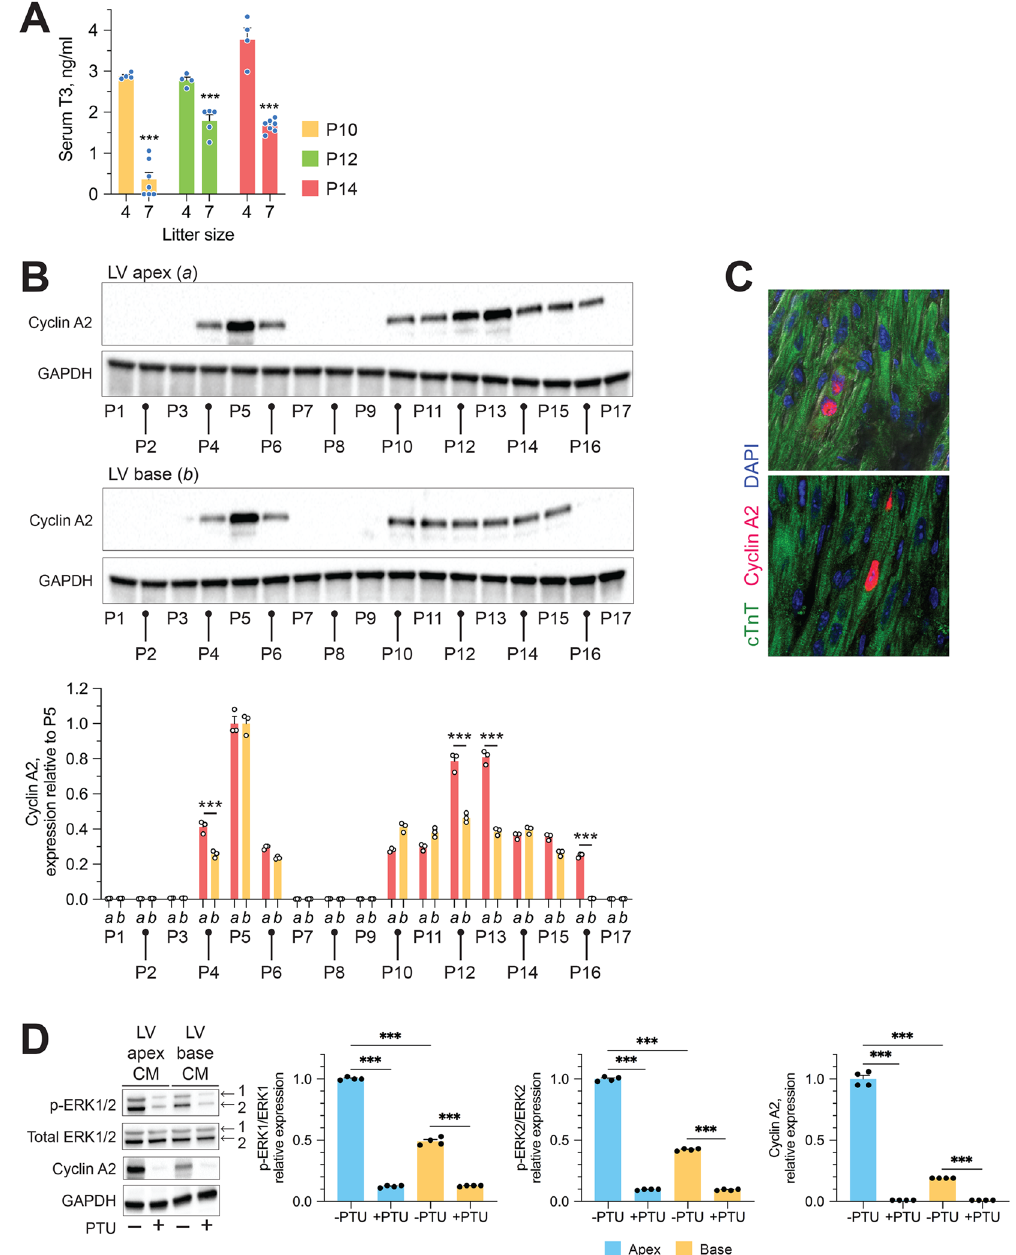
Figure 3. Spatial restriction of cardiomyocytes proliferative signaling to the LV apex during preadolescence. ( A ) Effect of litter size on developmental surge in circulating T3 during early preadolescence. ( B ) Representative immunoblots showing developmental changes in myocardial Cyclin A2 levels in the LV apex ( a ) and base ( b ) of early postnatal hearts. Bar graphs show GAPDH-normalized cyclin A2 levels relative to levels in P5 LV myocardium. ( C ) Two examples of a cyclin A2 + cardiomyocyte in a P13 LV apical tissue section. No cyclin A2 + cardiomyocytes were seen on sections of P13 LV base. ( D ) Representative immunoblots show expression levels of indicated proteins in whole cardiomyocyte (CM) lysates obtained from CMs of the LV apex and base at P13. Immunoblots show that developmental increases in p-ERK1/2 and Cyclin A2 in LV apical CMs of P13 mice are suppressed by PTU treatment that blocks T3 biosynthesis. Quantitative data is shown next to the immunoblots. *** P < 0.001. Data are mean ±